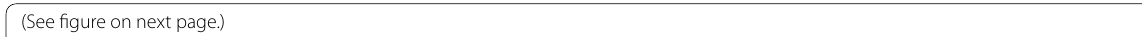
10). A The weight of COPD rats. =